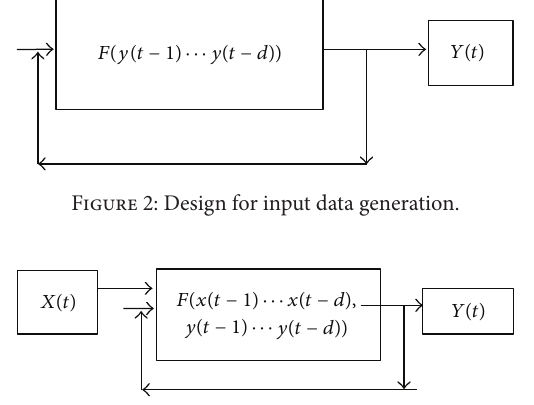
Figure 3: Design of output prediction using